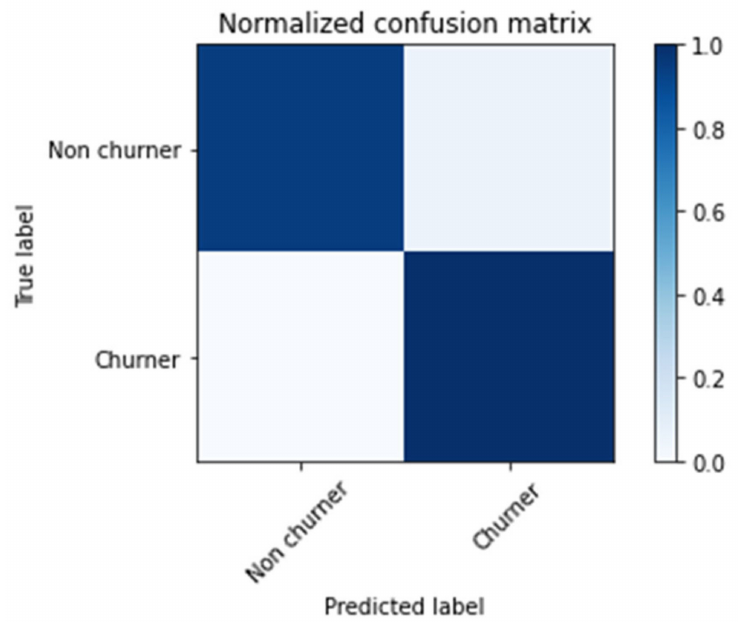
Figure 9. Normalised confusion matrix of the SentiChurn model.